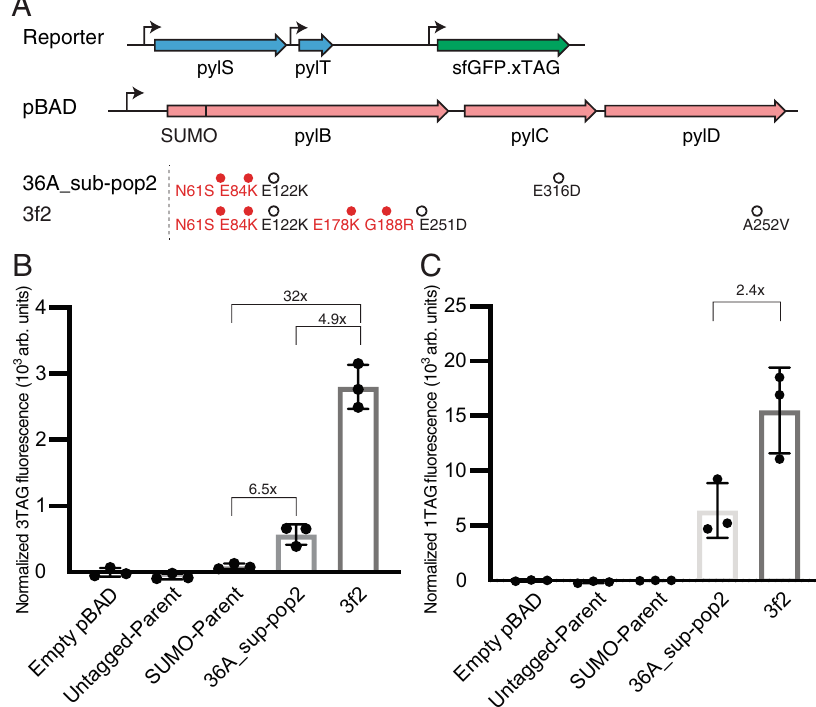
Fig. 3 Evolved biosynthetic pathway mediates improved Pyl protein yield. A The best evolved variant (36A_sub-pop2) and best combinatorial variant (3f2) contained a total of four and seven mutations, of which two and four were convergent mutations (red), respectively (for further mutation analysis of subpopulations, see Supplementary Tables 2 and 3). B When tested in E. coli strain C321. Δ A.exp, read-through of three amber codons in sfGFP is improved 32-fold in variant 3f2 combinatorial variant and 6.5-fold in variant 36A_sub-pop2, relative to the parental variant SUMO- pylBCD . The WT pylBCD pathway (termed “ Untagged Parent ” ) did not have detectable activity. C Read-through of one amber codon in sfGFP is improved 2.4-fold in variant 3f2, relative to variant 36A_sub-pop2. The WT pylBCD variant and the SUMO- pylBCD did not have detectable activity in this assay. In panels B and C , fl uorescence intensity shown (excitation 488 nm, emission 509 nm) was normalized by optical density ( A 600 ) (see “ Methods ” ). Samples were tested in biological triplicate; data shown represents mean values±